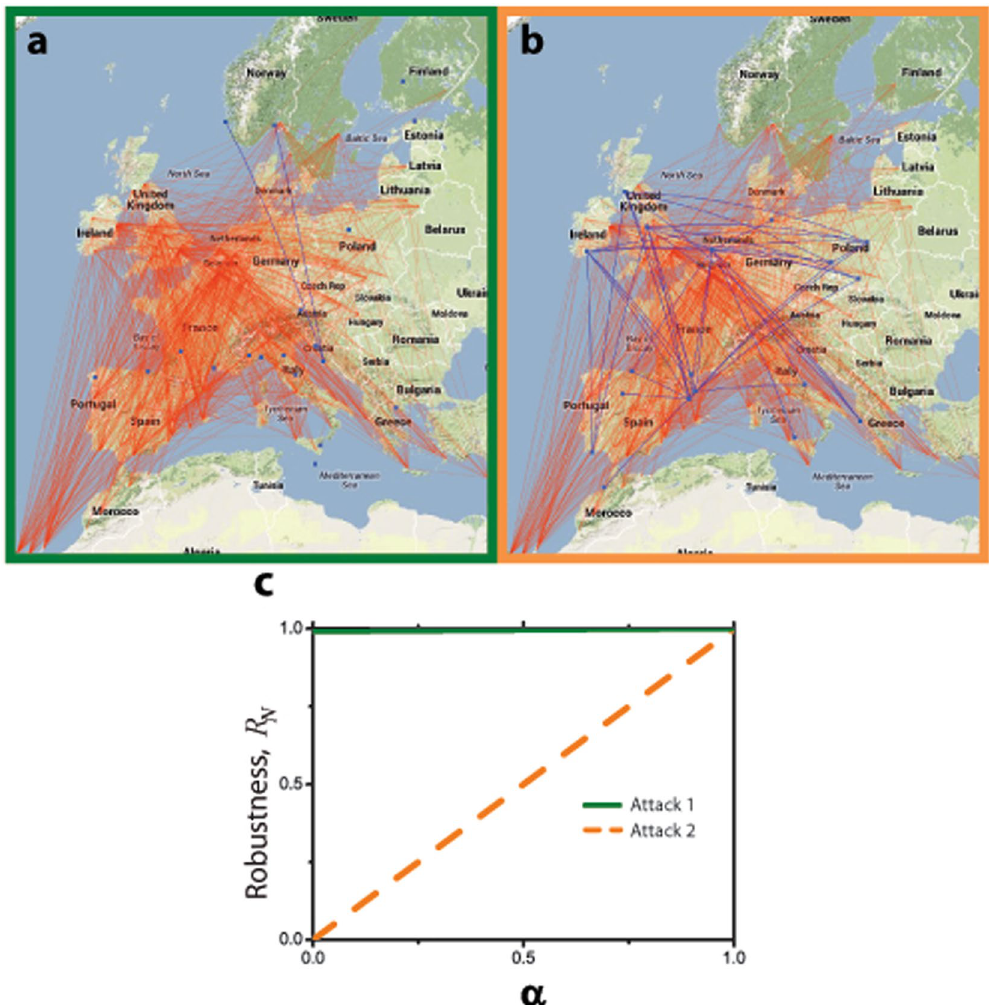
Figure 5. Importance of the dual connectivity perspective framework in assessing network robustness. The maps illustrate the result of two different attacks, Attack 1 and Attack 2, applied to the network until 19 airports are disconnected (10% removal). The two resulting networks have the same largest cluster size in the Active Network ( S A = 167), but different largest cluster size in the Idle Network: ( a ) S I = 3 for Attack 1 and ( b ) S I = 19 for Attack 2. Considering connectivity of the Idle Network in assessing the system robustness reveals significant differences in these two attacks, as quantified in ( c ). The maps were generated using the Google Maps API and Map Data ©2014 Google